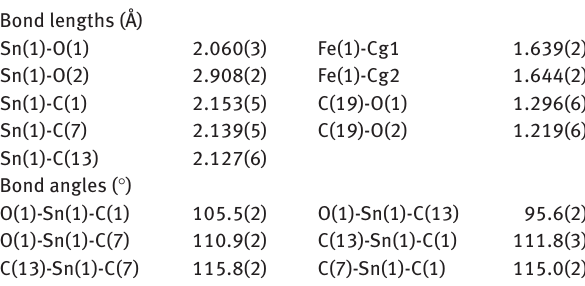
Table 1 Selected bond lengths (Å) and angles ( ° ) for 1 .